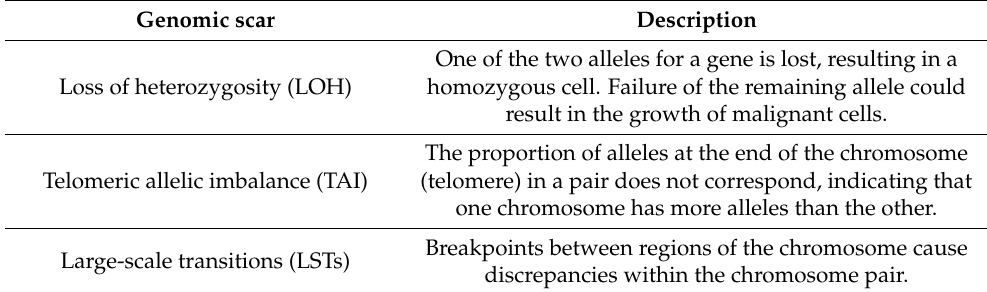
discrepancies within the chromosome